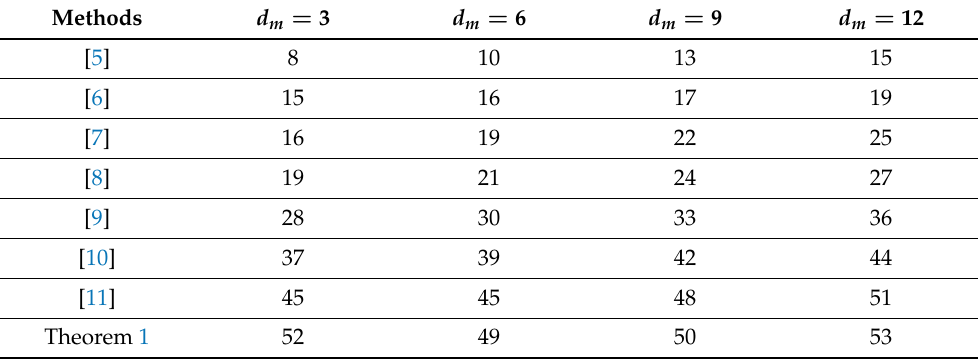
Table 1. Calculated maximum d M for various d m